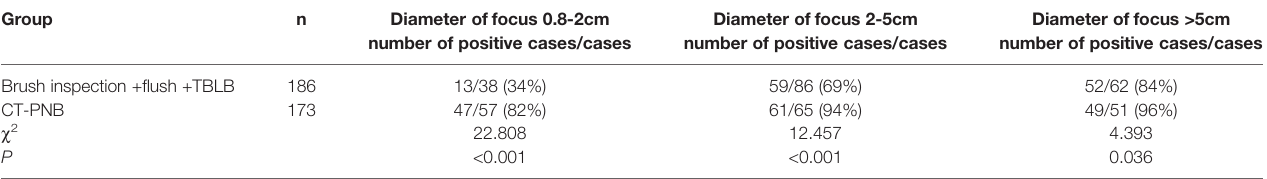
TABLE 2 | Comparison of joint sampling method under fi beroptic bronchoscopy and CT-PNB sampling method. Group